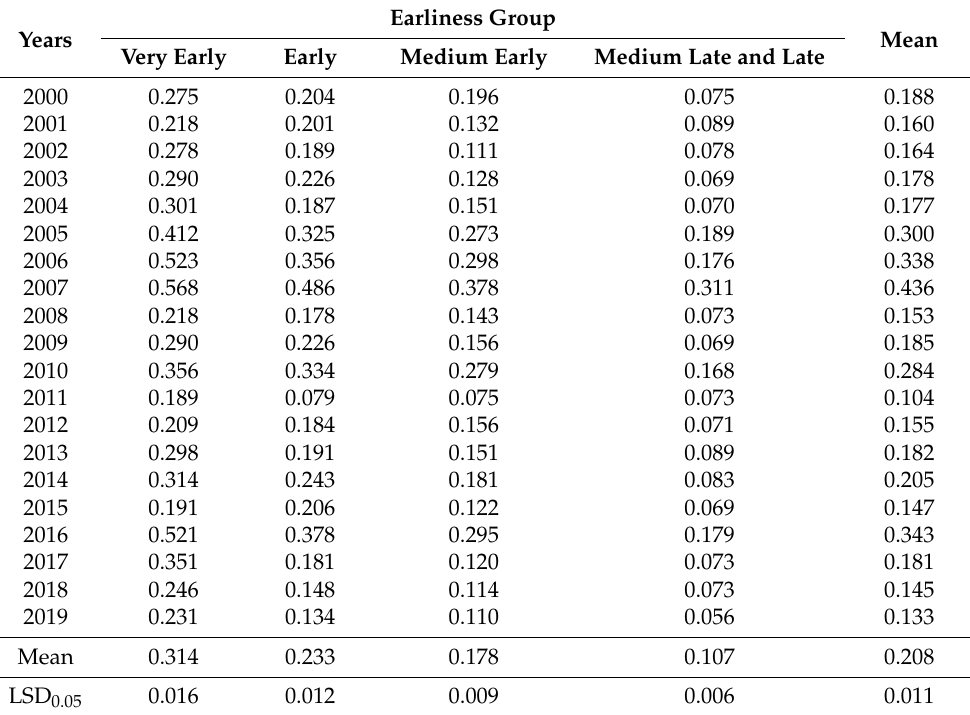
Table 4. Infection coefficients of Phytophthora infestans in the